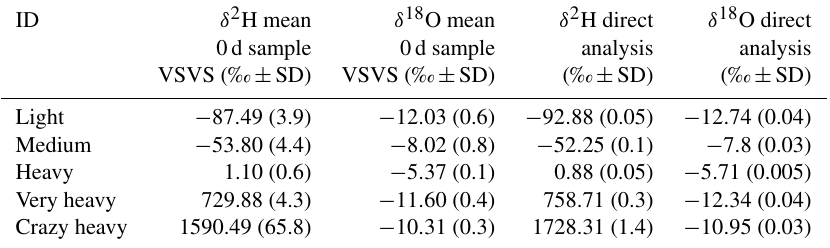
Table 1. Means and standard deviation (SD) for the five sources observed immediately after the vials were filled (“0d” samples), as well as values for δ 2 H and δ 18 O determined by liquid water measurements on a CRDS. Mean for “0d” samples derived from 10 replicates ( n = 10), values for direct analysis derived from 10 injections in the “high-precision” mode of the CRDS.